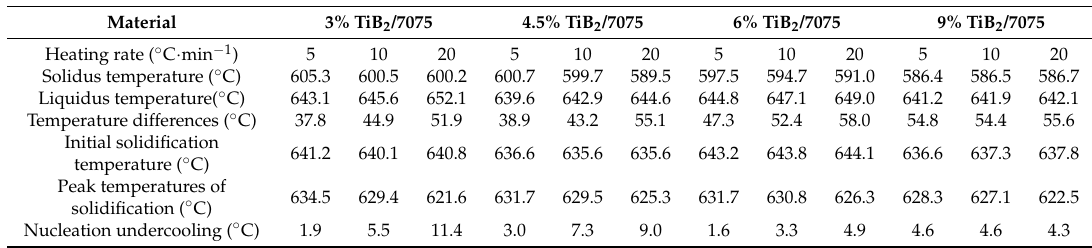
Table 1. Parameters of the melting and solidification process of